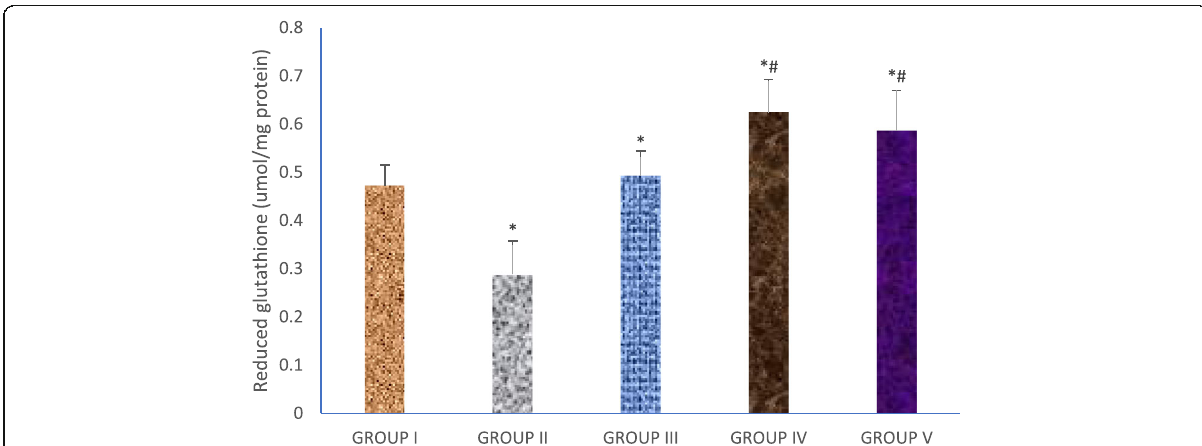
Fig. 8 Influence of MLVA on testicular glutathione (GSH) content of rats treated with nitrobenzene. Data are given as mean ± SD of rats per group. n = 6. MLVA: methanolic leaf extract of Vernonia amygdalina , *: Values differ significantly from group I (control) ( P < 0.05). #: Values differ significantly from group